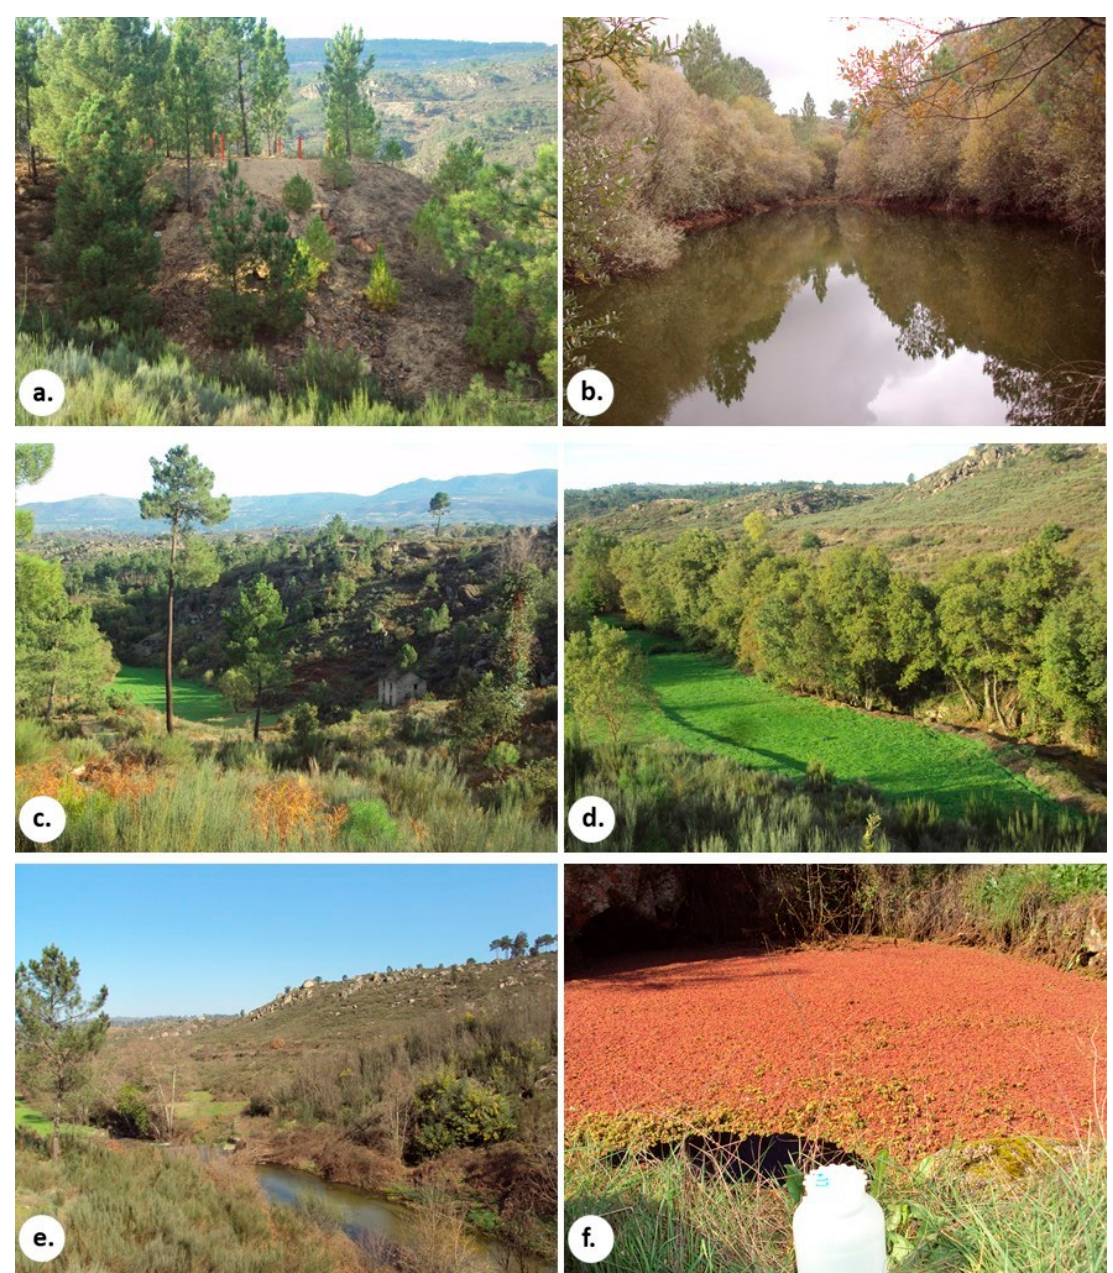
Figure 1. Images illustrating the old abandoned mine area of Canto Lagar (Central Portugal): ( a ) mine dumps; ( b ) open pit; ( c ) pasture areas; ( d ) agricultural activities in the S. Paio stream margin; ( e ) S. Paio stream; ( f ) well located in the stream margins.